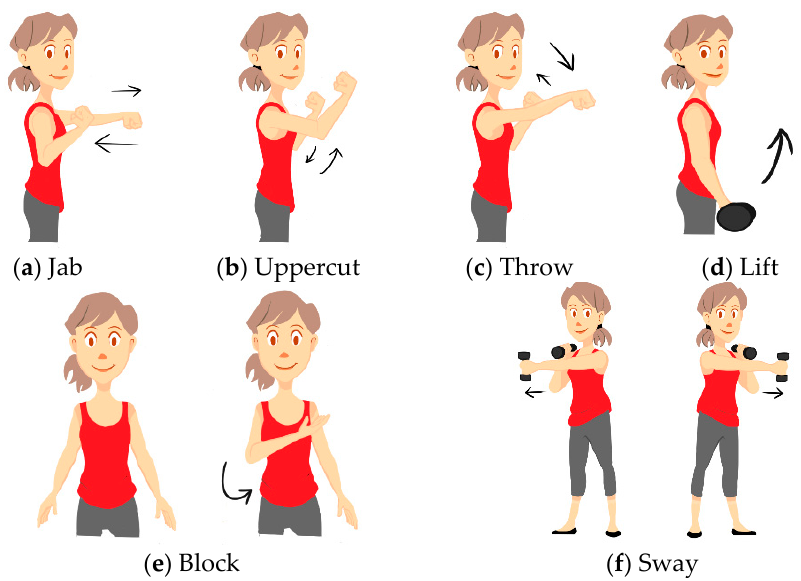
Figure 7. Gestures performed during each study. ( a ) Jab; ( b ) Uppercut; ( c ) Throw; ( d ) Lift; ( e ) Block; ( f ) Sway.